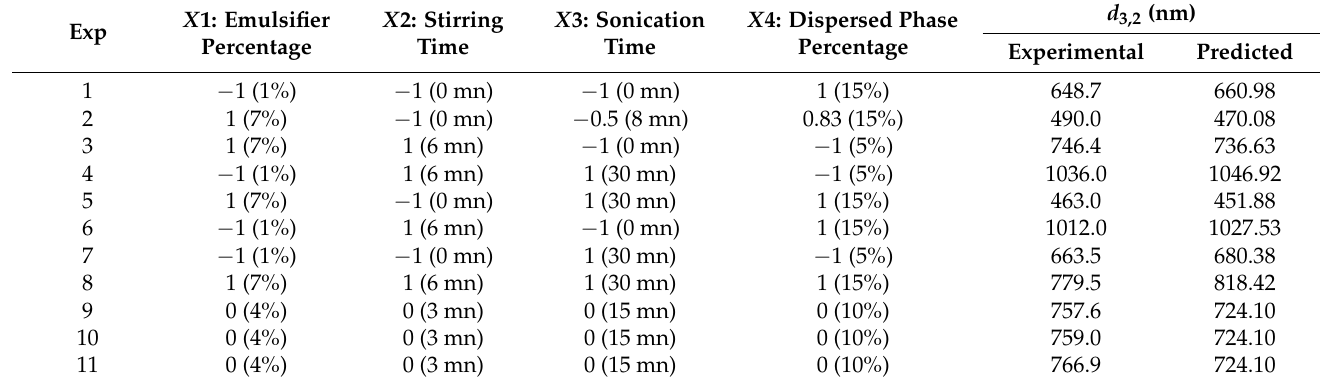
Table 1. Coded levels and conditions run with the experimental and predicted values used